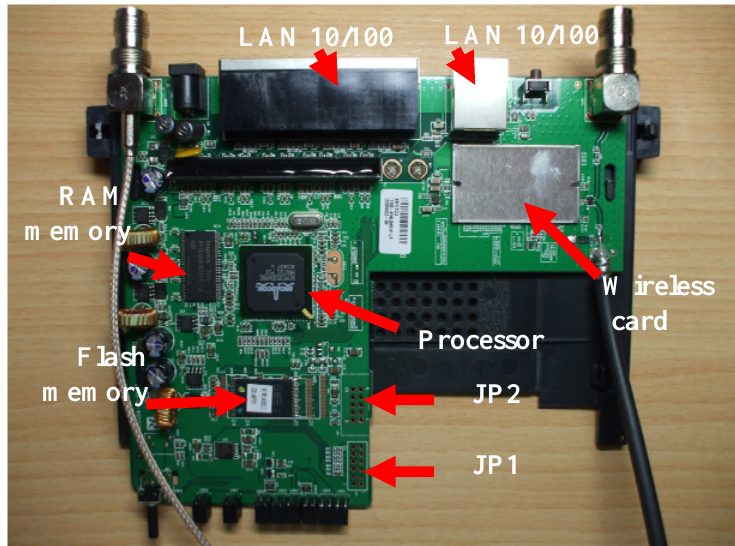
Figure 6. Hardware distribution on